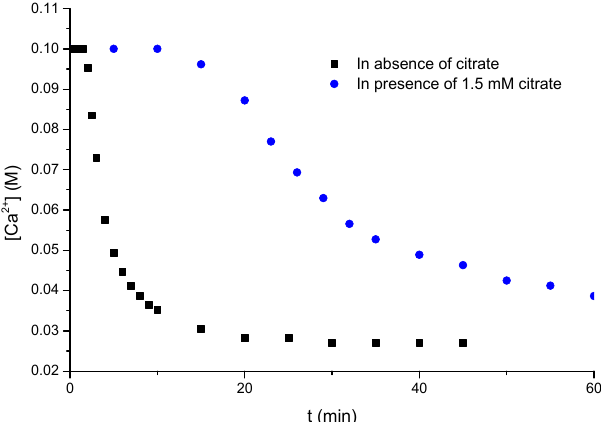
Figure 3. The variation of [Ca 2 + ] during the reaction of Na 2 SO 4 + CaCl 2 + 2 H 2 O → 2 NaCl + CaSO 4 · 2H 2 O with 0.1-M initial reactant concentration in absence and in presence of 1.5-mM citrate.